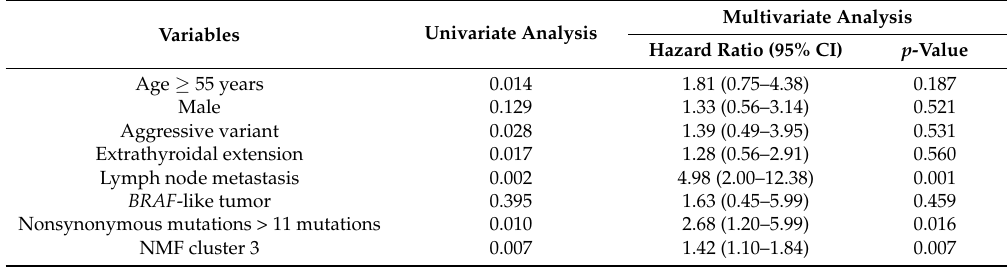
Table 3. Univariate and multivariate Cox regression analyses for recurrence free survival in the papillary thyroid carcinoma TCGA dataset. CI: confidence